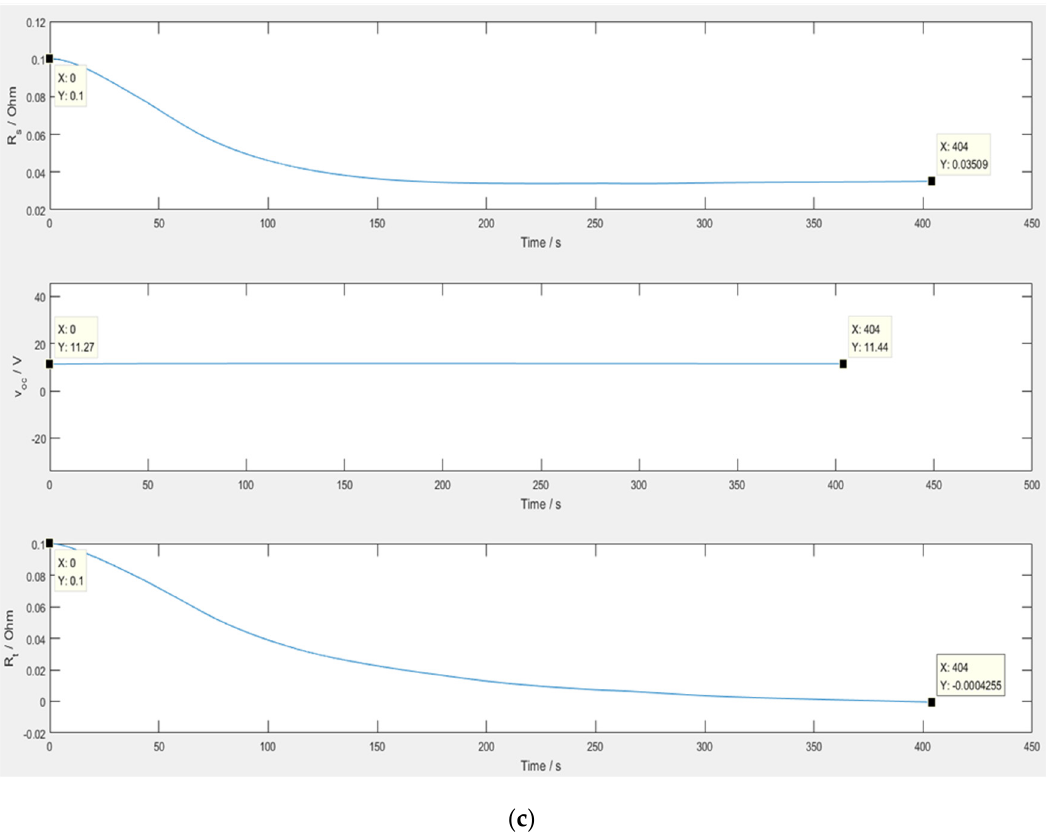
Figure 7. ( a ) Terminal voltage, discharge current, and estimating error; ( b ) estimating model parameters, θ(cid:3552) (cid:3036) , i = 1~4; ( c ) estimated Rs, Rt, and voc in Experiment